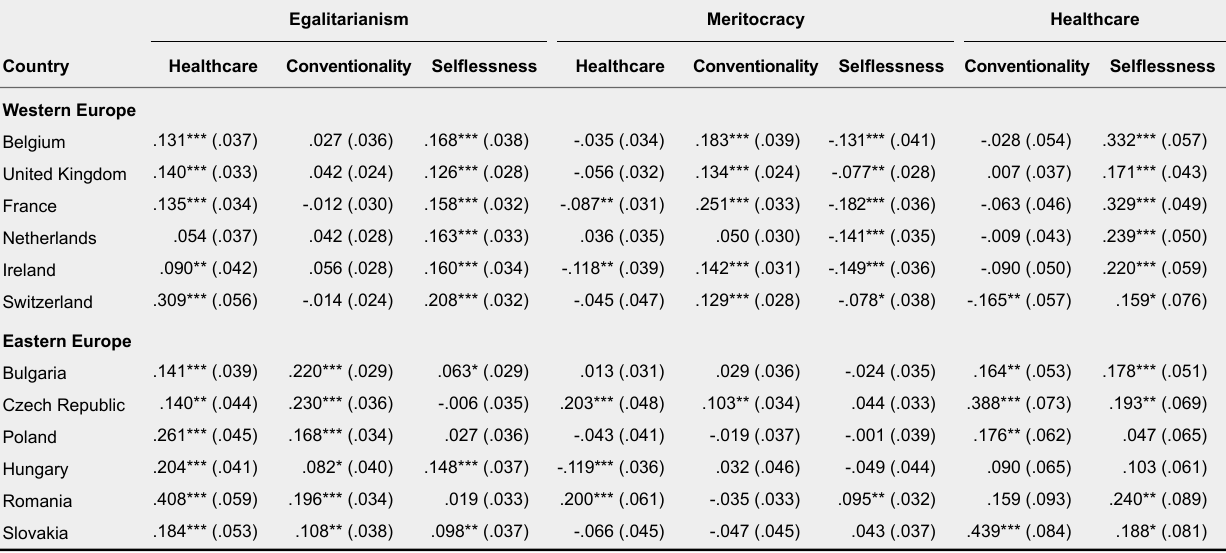
Regression Coefficients of Pathway Models Explaining Support for Healthcare Services Based on National Samples